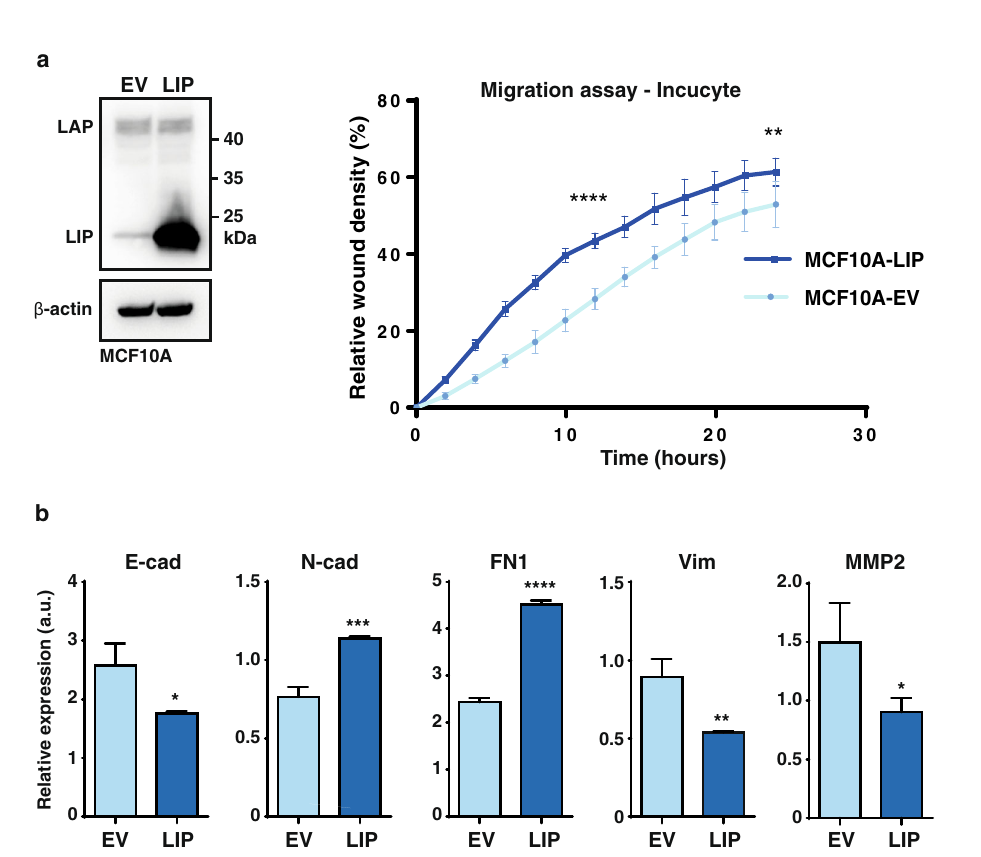
Fig. 4 C/EBP β regulates a subset of EMT markers. a Immunoblot showing the expression of LAP and LIP in MCF10A cells containing an expression vector for LIP or empty vector control (EV). β -actin was used for loading control. At the right, a time course of Incucyte migration assay is shown as relative wound closure density of MCF10A cells containing a LIP expression construct or empty vector control (EV) ( n = 8). Statistical differences were analysed for timepoints 12 h and 24 h using a -T-test. b Expression of epithelial and mesenchymal genes relative to GAPDH in MCF10A cells containing a LIP expression construct or empty vector control (EV) ( n = 3). Results are analysed using a T-test. Error bars represent SD, * p < 0.05, ** p < 0.01, *** p < 0.001, **** p < 0.0001. we provide evidence that the expression ratio of the C/EBP β migration in MCF10A mammary epithelial cells or in Cebpb - protein isoforms LIP and LAP determines cell migration and cell de fi cient MEFs, suggesting that LIP in general supports cell invasion behaviour and contributes to the regulation of EMT- and migration. Breast cancer metastasis is a multistep process by ECM-related genes. We show that reverting the high LIP/LAP which cells have to migrate, invade, extravasate, intravasate and expression ratios typical for TNBC cells into low LIP/LAP ratios by colonise at distant target sites. Dissemination of tumour cells from the ectopic overexpression of LAP inhibits cell migration and invasion. primary tumour requires cells to lose polarity and become migratory In addition, we show that overexpression of LIP promotes cell and invade the surrounding basement membrane and ECM.